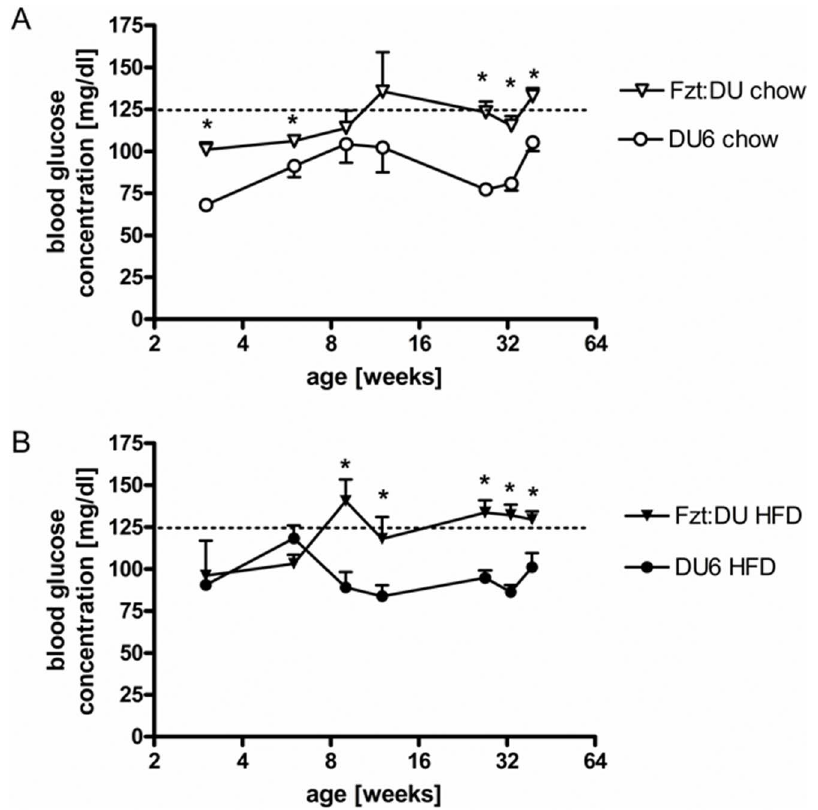
Figure 3. Longitudinal study of fasting glucose levels in male DU6 mice fed chow (A) or a high fat (B) diet (n week3 =4 ; n week27 . 13; *: P , 0.05).